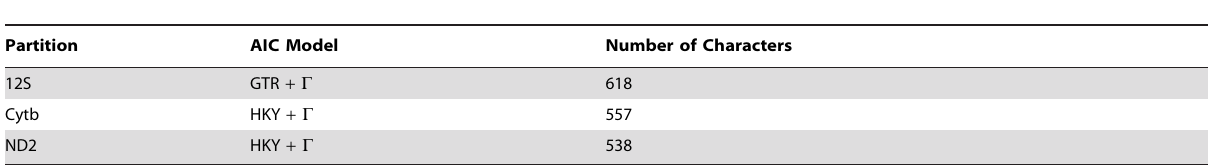
Table 1. Models of evolution selected by AIC and applied for partitioned, phylogeographic analyses 1